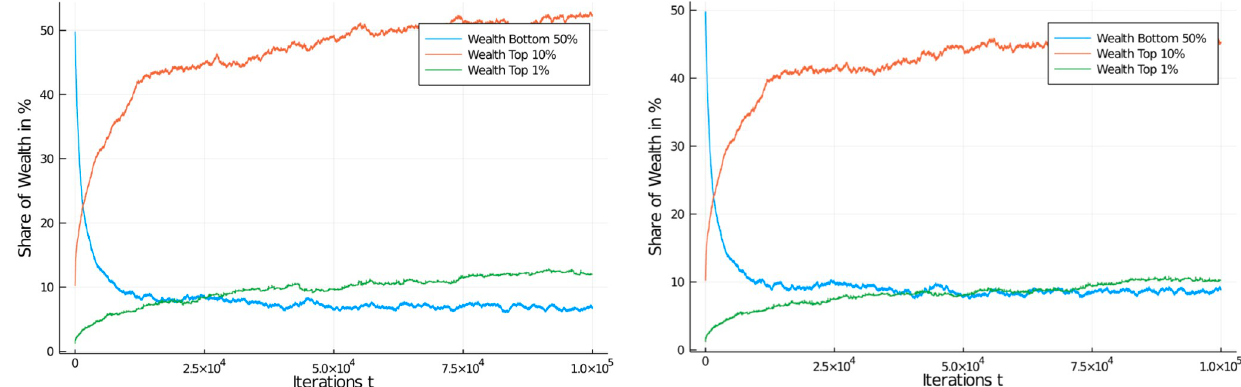
Fig 9. Comparison of progressive income tax regimes. Wealth development in different quantiles of the population of 1,000 agents. Progressive income tax regime, with tax rate of between 15% and 60%, linearly growing in the income interval from $150 to $1,200 (left) and between 15% and 75%, linearly growing in the income interval from $150 to $1,550 (right). Initial distribution was equal among all 1,000 agents. Quantiles shown: Bottom half of the population vs top 10% and top 1% wealthiest agents.